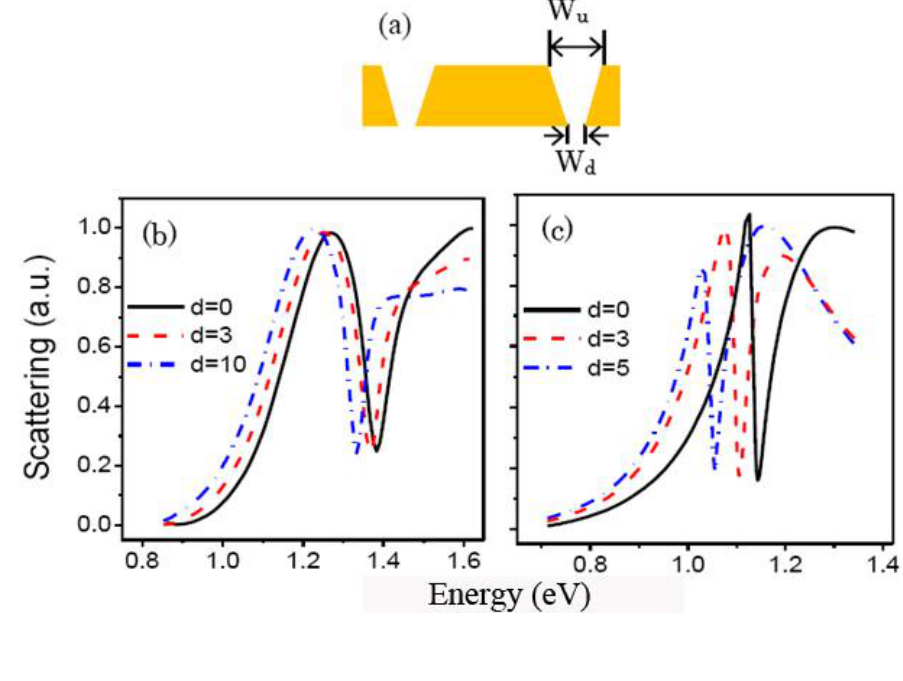
of 20 nm and 10 nm, u